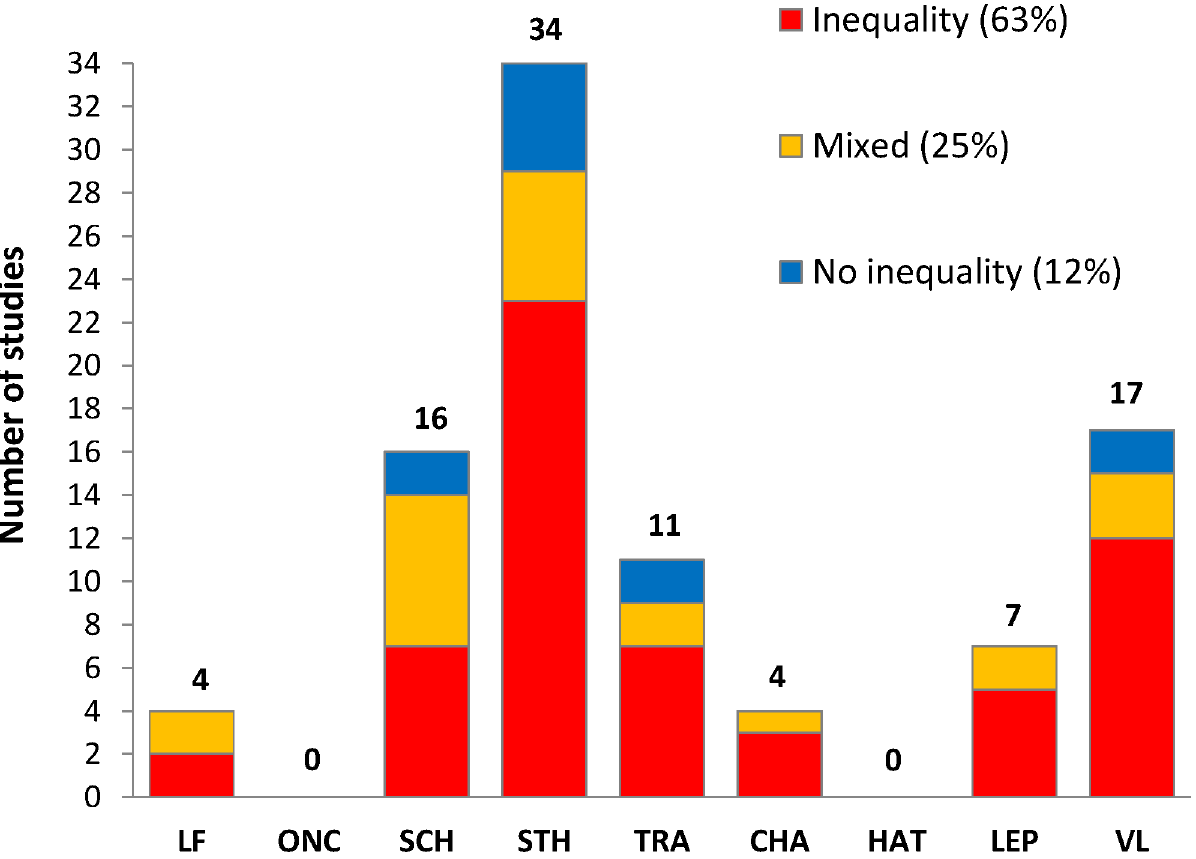
Fig 3. Number of papers reporting greater odds of infection among lower socioeconomic strata than among higher socioeconomic strata, number of papers reporting mixed results, and number of papers reporting no inequality or a reverse association, 2004 – 2013. Inequality : Statistically significant ( p < 0.05) inequality in NTD distribution, with greater odds of infection among lower socioeconomic strata. This also includes papers reporting statistically significant inequality for one SEP indicator and nonsignificant inequality of at least 50% greater odds of infection among lower strata for another SEP indicator. The same criterion was used for socioeconomic inequality in NTD prevalence in one age group and not in another age group and for one NTD outcome measure and not for another NTD outcome measure. Mixed : Studies reporting a combination of statistically significant inequality — with greater odds of infection among lower socioeconomic strata — for one SEP indicator, age group, or NTD outcome measure and no such inequality (or reversed pattern) for another SEP indicator, age group, or NTD outcome measure. No inequality : Studies reporting no substantial and statistically significantly greater odds of infection among lower socioeconomic strata or reporting a reverse pattern, with greater odds of infection among higher strata. Of the 93 publications included in the review, two studies (Balen et al. 2011 and Steinmann et al. Acta Tropica 2007) reported findings for both schistosomiasis and STH separately. In the figure, we included these studies under both schistosomisasis and STH. Two other studies that reported on combined schistosomiasis and STH infection in the same individuals were not included in this figure (one reported inequality, the other no